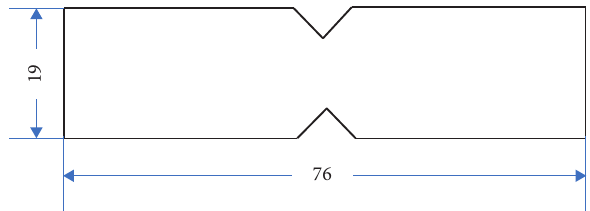
Figure 2: Dimensions of the shear (Iosipescu) test of composite as per ASTM